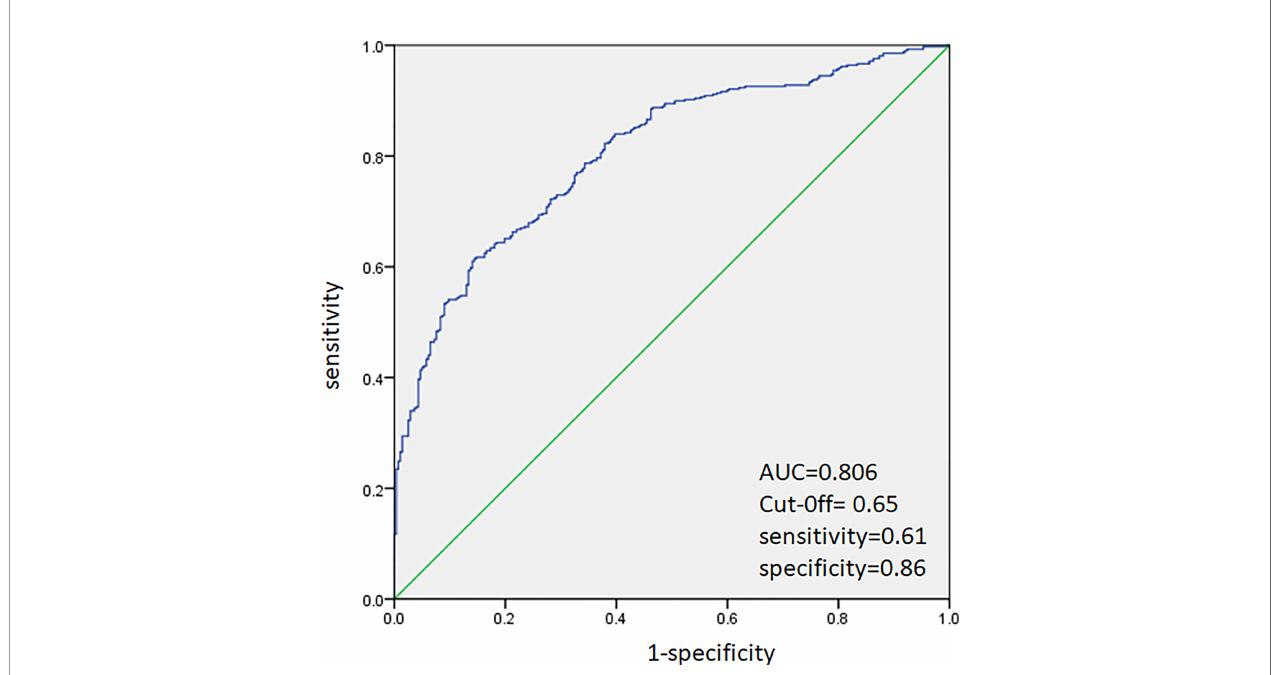
FIGURE 1 | Receiver operating characteristic curve analysis for prediction of central lymph node metastases using the multivariate model in PTC